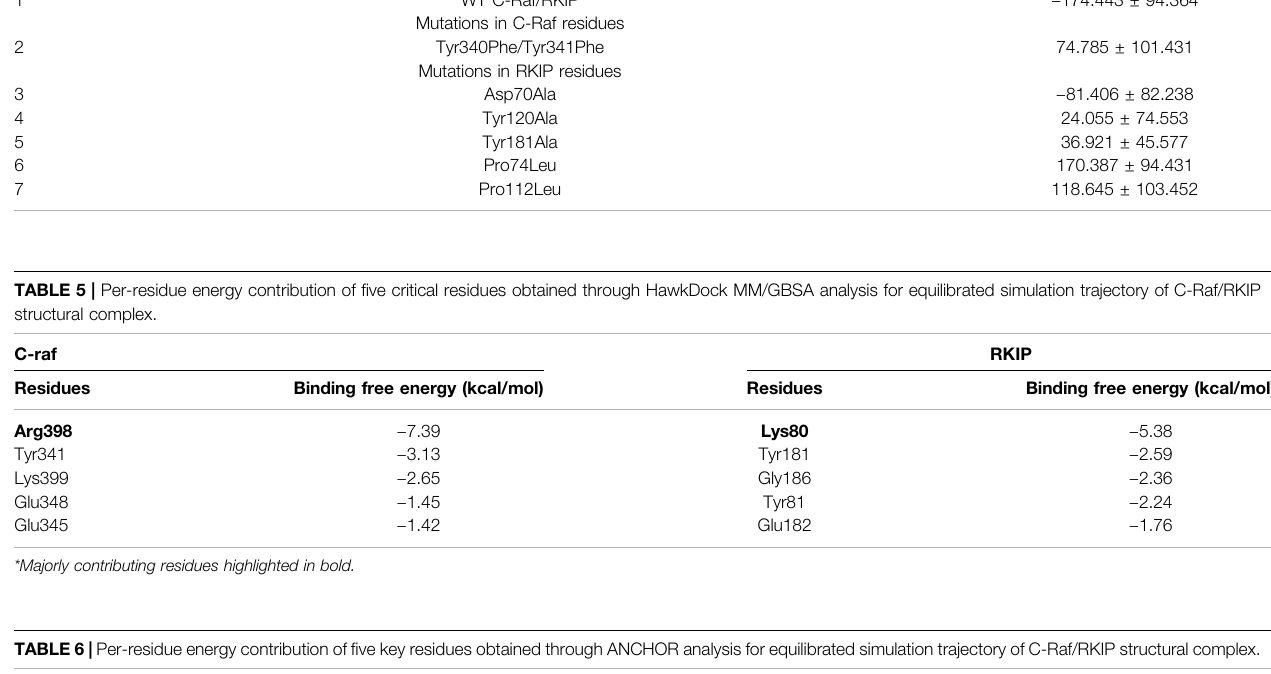
TABLE 6 | Per-residue energy contribution of fi ve key residues obtained through ANCHOR analysis for equilibrated simulation trajectory of C-Raf/RKIP structural complex. C-raf RKIP Residues